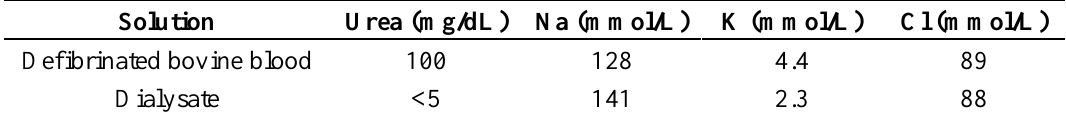
Table 1. Urea, Na, K and Cl concentrations in defibrinated bovine blood and dialysate. Solution Defibrinated bovine blood